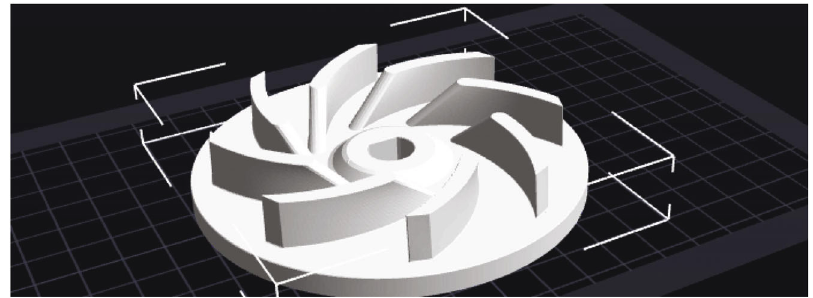
Figure 13: Polymer impeller CAD design into slicing softer image (online free software: Flashforge